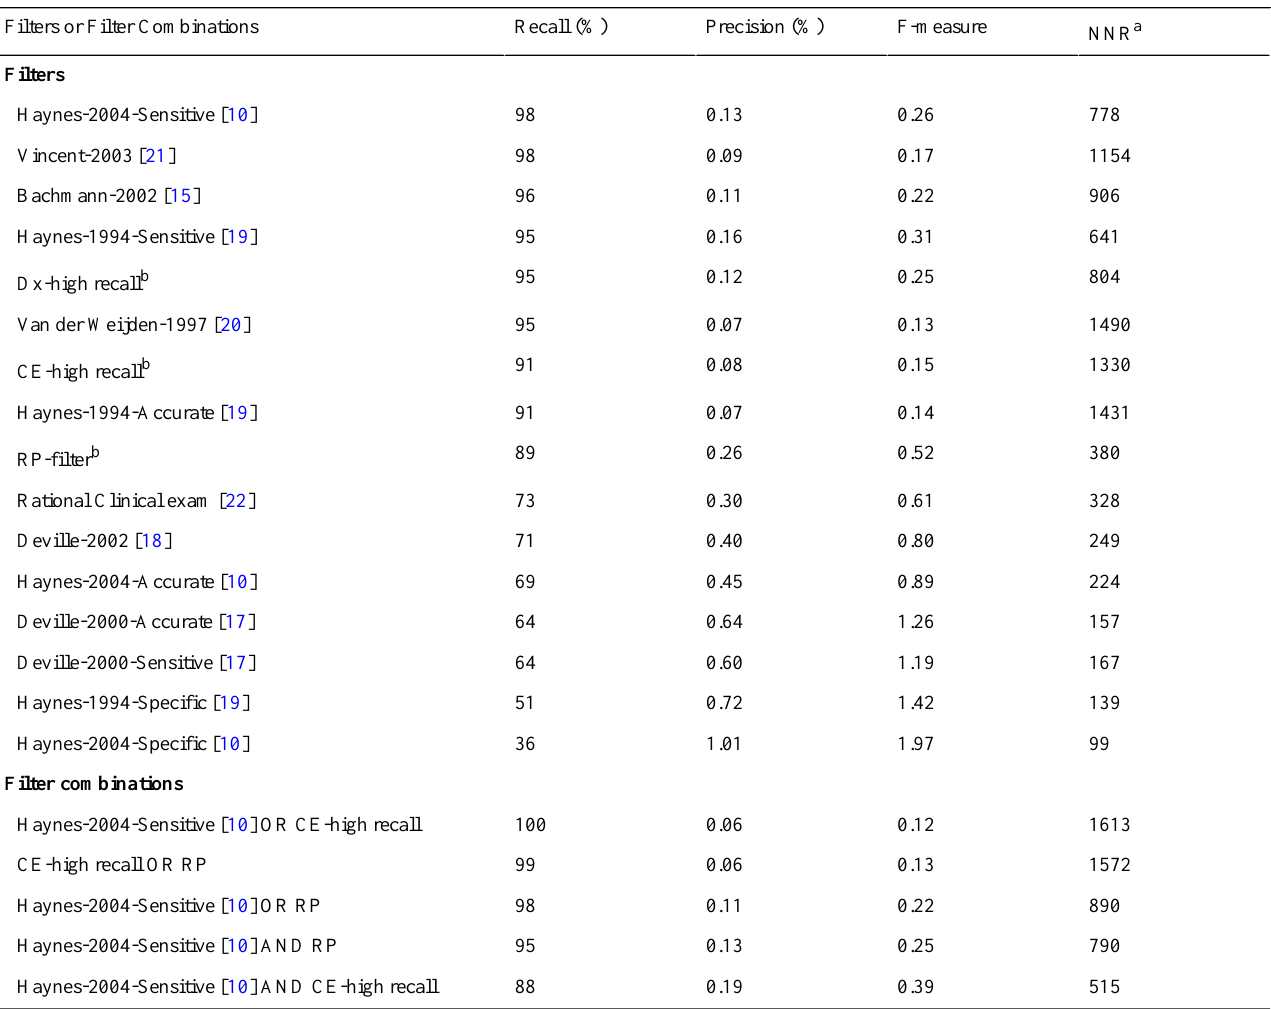
Table 3. Performance of the search filters in the testing database sorted according to